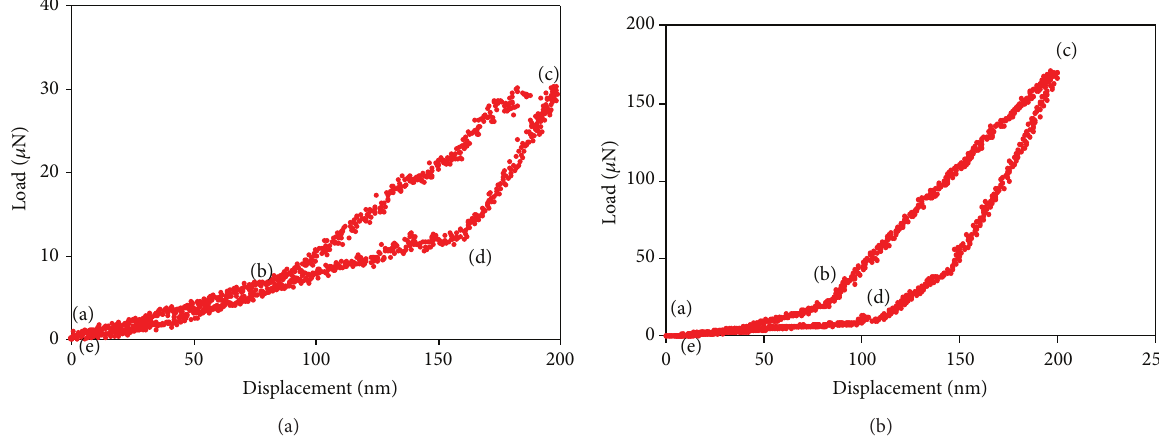
Figure 3: Experimentally observed loading and unloading behavior by indenting on the center of the span of 2.0 𝜇 m (a) and 1.5 𝜇 m (b) of GaN nanobeams with equal indentation depth using a conical indenter in